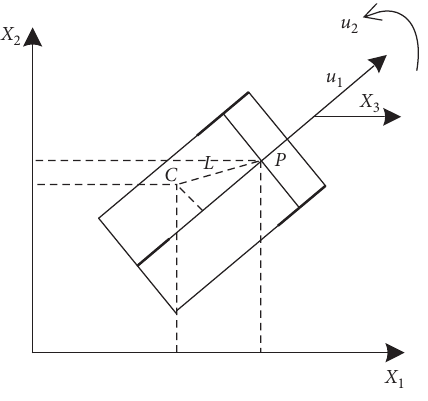
Figure 1: Wheeled mobile robot